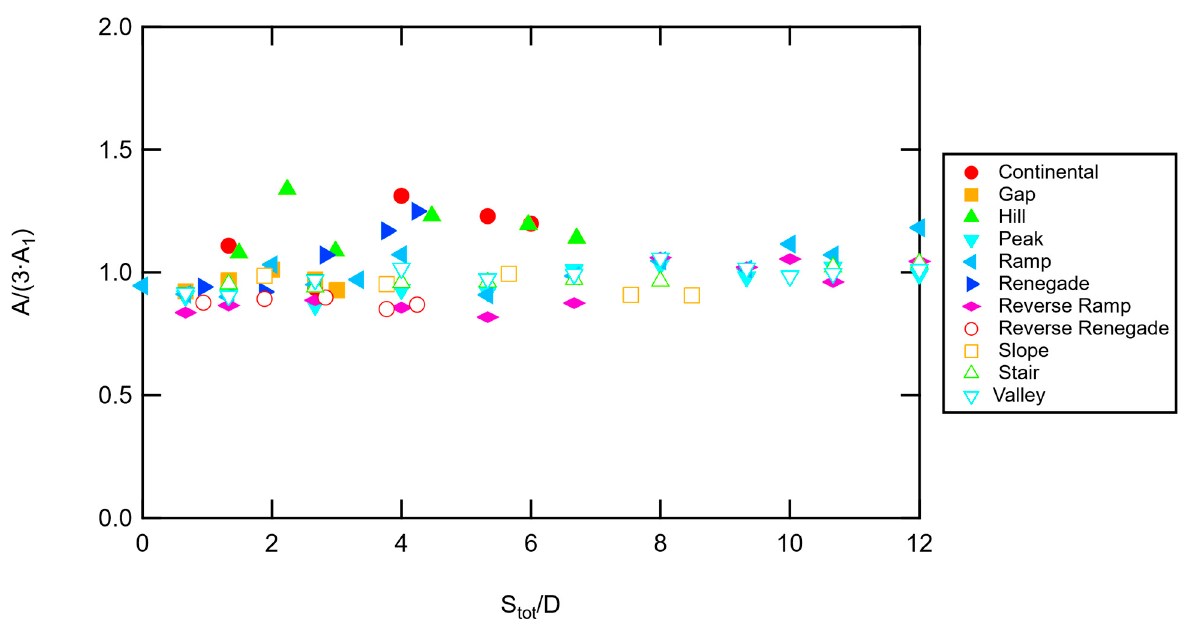
Figure 14. Flame area ( A ) vs. total separation ( S tot /D ) from experiments with 3 pads. Total flame area here was normalized by three times the average flame area of single pad experiments. Configurations are shown in Figure 2.